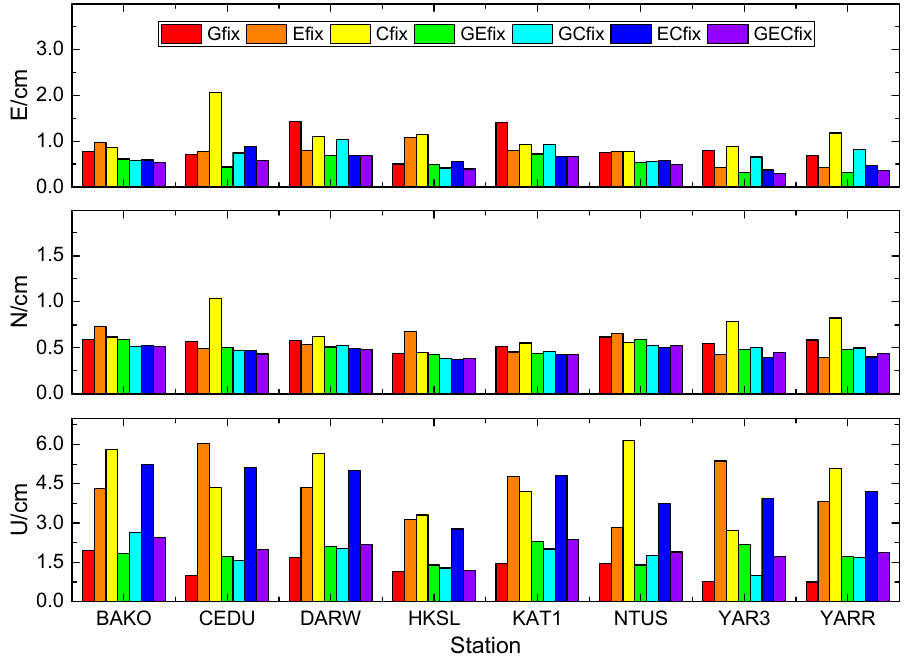
Figure 13. The average RMS of the fixed PPP solution from DOY 321 to 350, 2018. Remote Sens. 2019 , 11 , x FOR PEER REVIEW